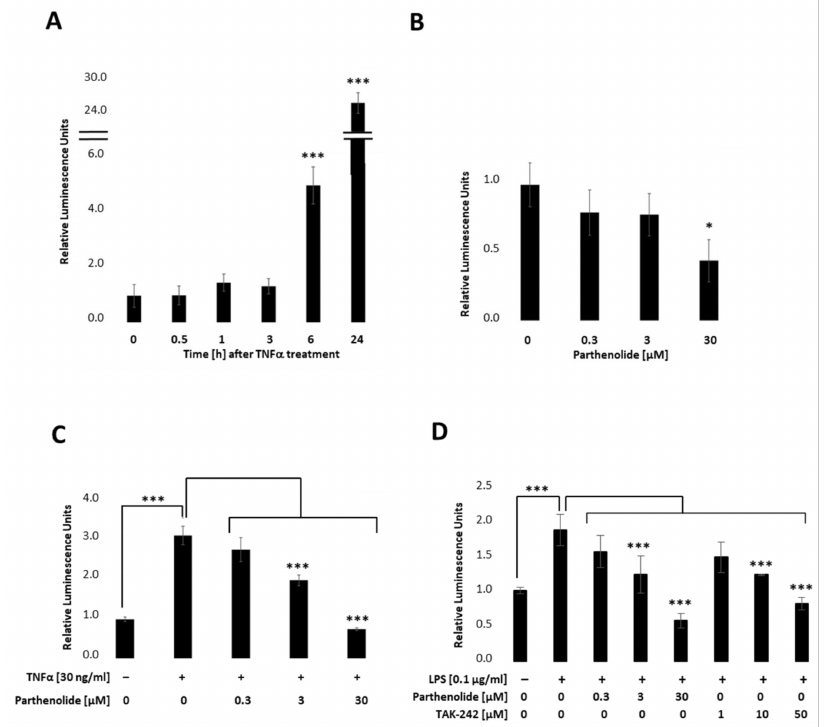
Figure 2. Relative NF- κ B promoter-linked Gaussian Luciferase activity in PANC-1 NF- κ B cells. PANC-1 NF- κ B cells were stimulated with ( A ) 30 ng/mL TNF α , ( B ) 0.3 µ M, 3 µ M, or 30 µ M PAR, or co-treated with TNF α and PAR and luciferase measured after (A ) 0, 0.5, 1, 3, 6, and 24 h, or ( B , C ) 24 h. ( D ) PANC-1 NF- κ B cells were non-treated, treated with 100 ng/mL LPS +/ − different concentrations of PAR (0.3, 3, 30 µ M) or TAK-242 (1, 10, 50 µ M) and luciferase was measured after 6 h. Post-ANOVA, multiple compar- isons relative to the control were performed using Dunnett’s test. Error bar = SD. n = 6; * p < 0.05; *** p <